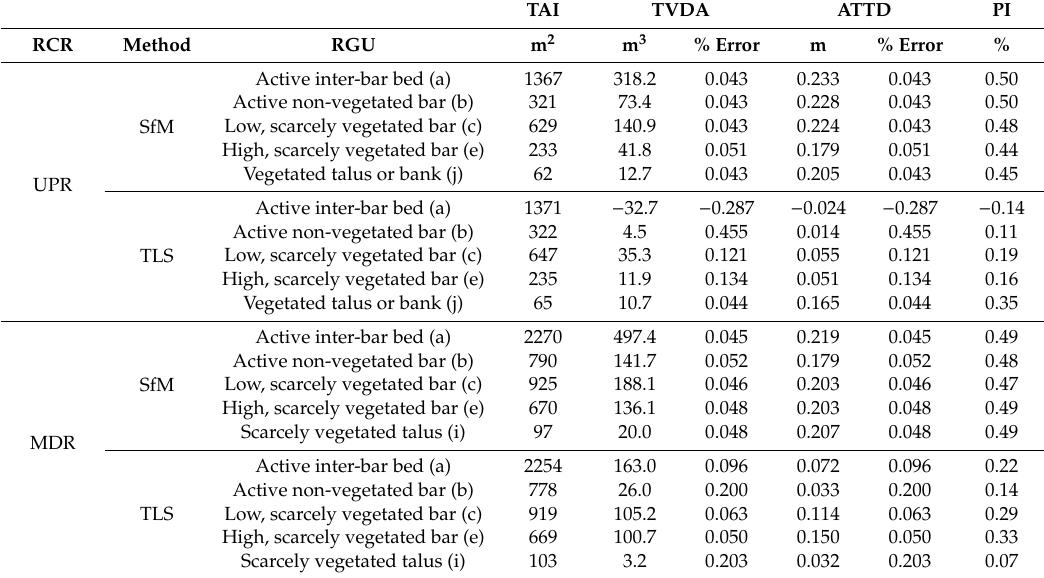
Table 4. Descriptors used to evaluate sediment budgets (sediment area and volume), and the associated errors, for RGUs within each of the RCR, in periods overlapped by the initial SfM and TLS surveys between September 2018 and September